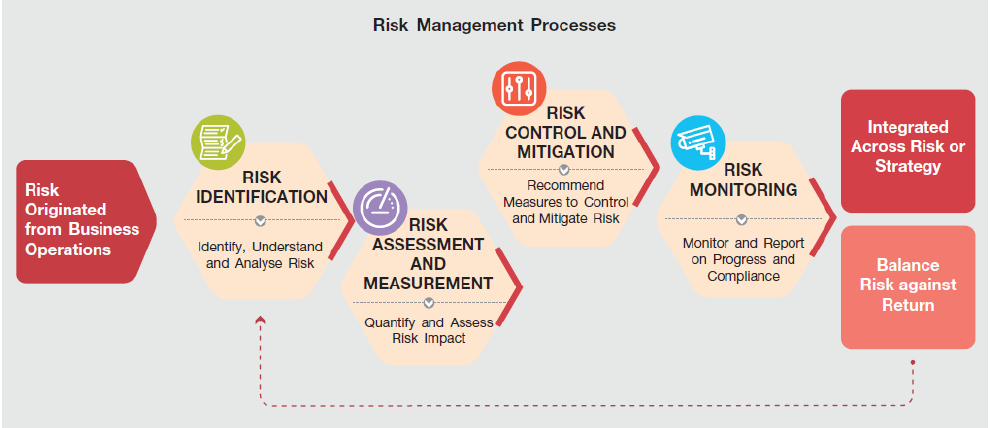
Figure 2. A diagram used to illustrate